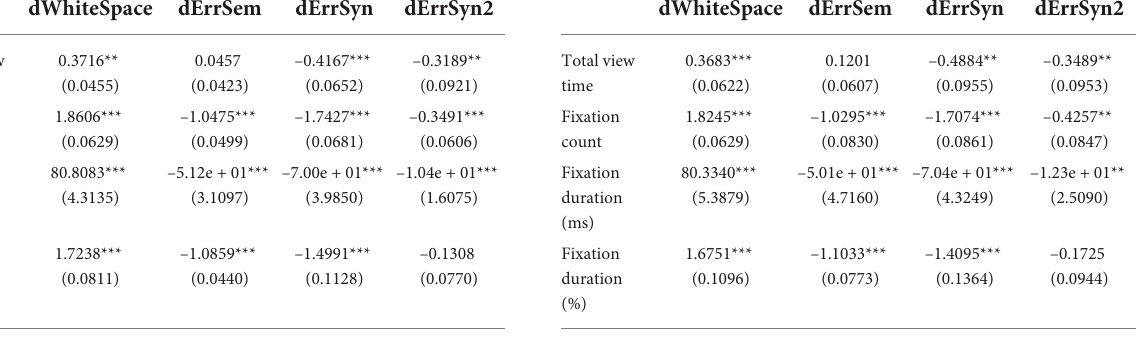
TABLE 2 Effect of errors type on attentional characteristics, when Expertise =